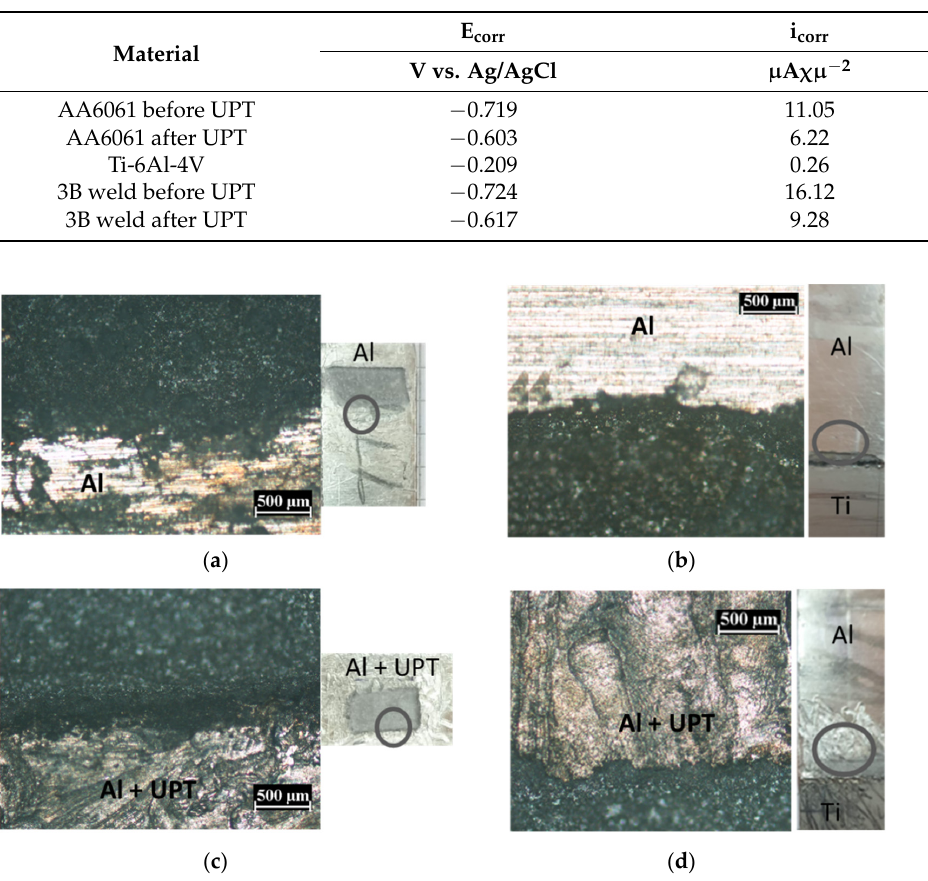
Figure 17. Pictures of corroded windows of the samples and optical micrographs of one edge of the corrosion window (circled in the pictures) for Al sample before UPT ( a ), Al sample after UPT ( c ), 3B weld before UPT ( b ) and 3B weld after UPT ( d ). Table 5. Corrosion potential and corrosion current density extracted from potentiodynamic polari- zation curves reported in Figure 16b.